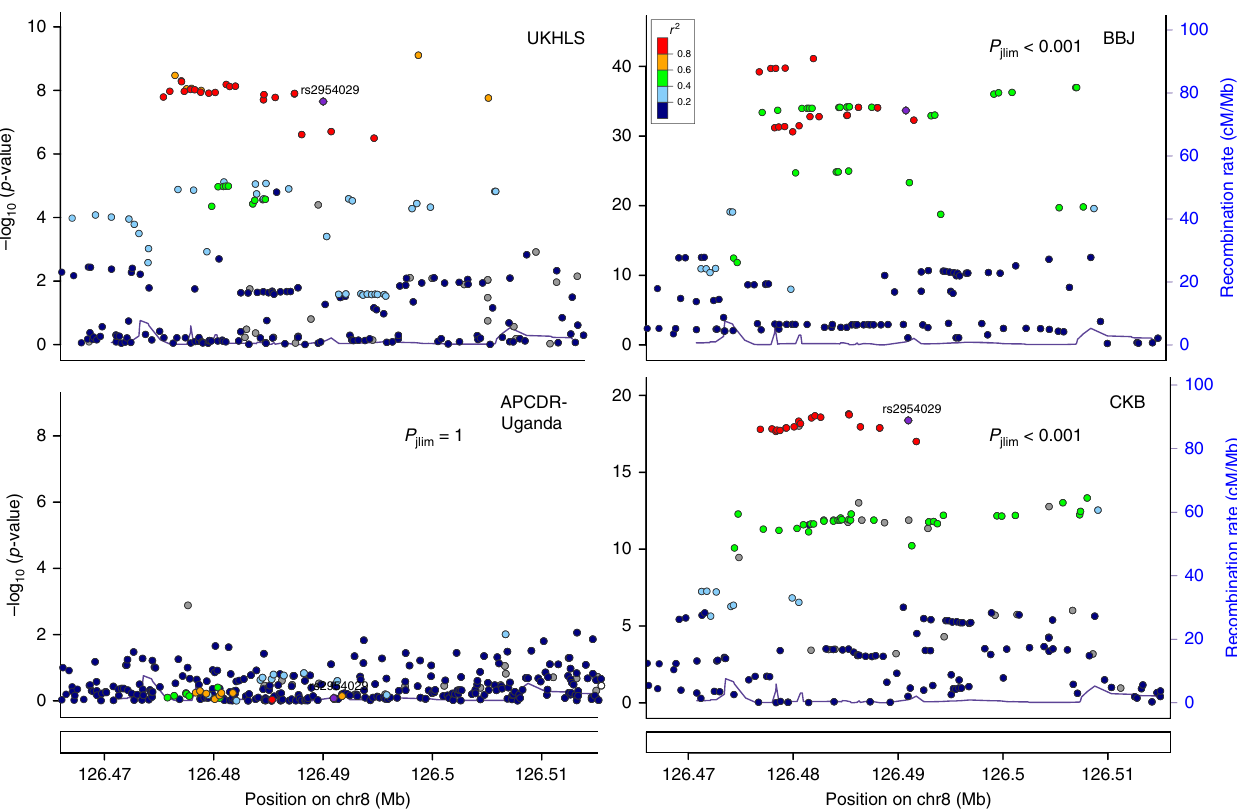
Fig. 4 Regional plots for SNP associations with triglyceride levels at established triglyceride-associated locus 8q24.13 for UKHLS, Biobank Japan (BBJ), APCDR-Uganda, and China Kadoorie Biobank (CKB) and p -value p jlim based on a permutation test for the trans-ethnic colocalization with UKHLS. Filling colour of the points corresponds to the strength of linkage disequilibrium (r 2 ) of each variant with the lead variant rs2954029